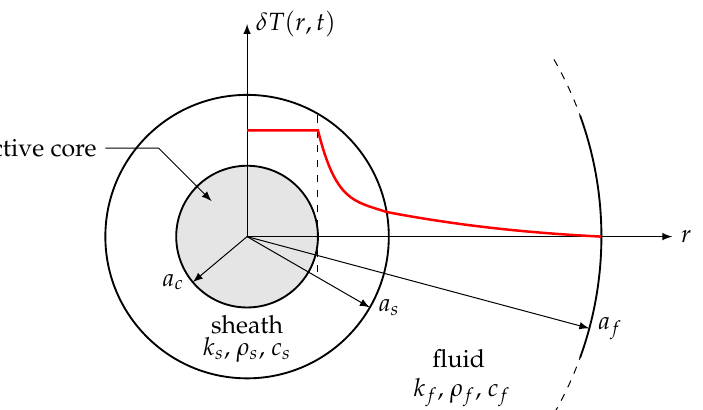
Figure 3. Ideal 1D effective model of a miniature bead-type NTC, immersed in a fluid at rest (with thermal conductivity k f , density ρ f , and specific heat c f ). The red curve represents effective variations of the δ T = T ( r , t ) − T 0 temperature through the system, as a function of r , at a given time t